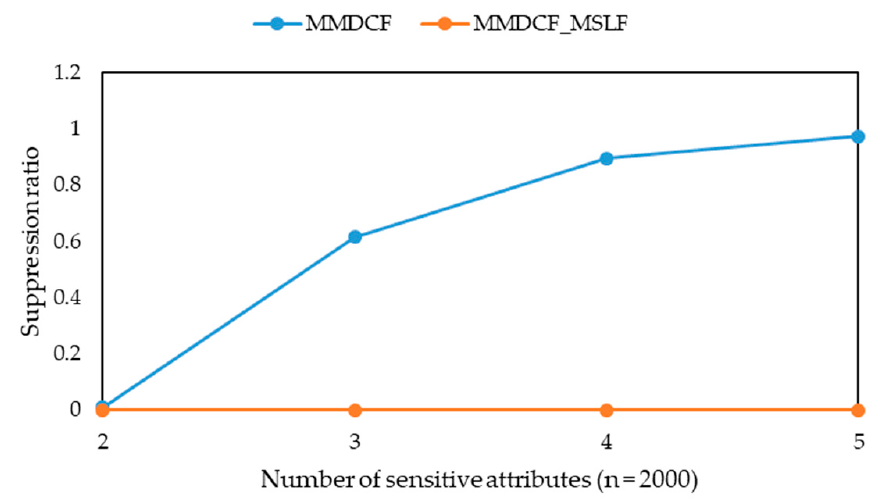
Figure 18. The suppression ratio of maximal multi-dimension-capacity first (MMDCF) and MMDCF-MSLF with di ff erent sensitive attribute numbers ( n = 2000).